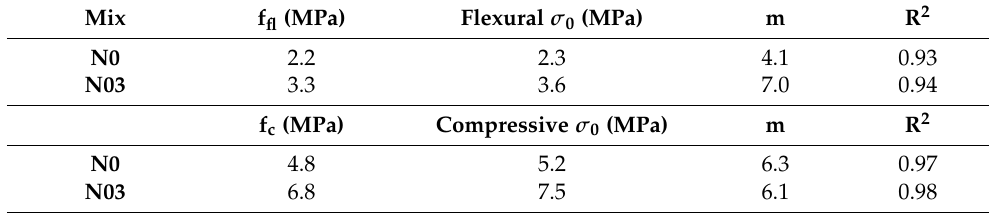
Table 6. Average experimental strength values and parameters obtained after Weibull